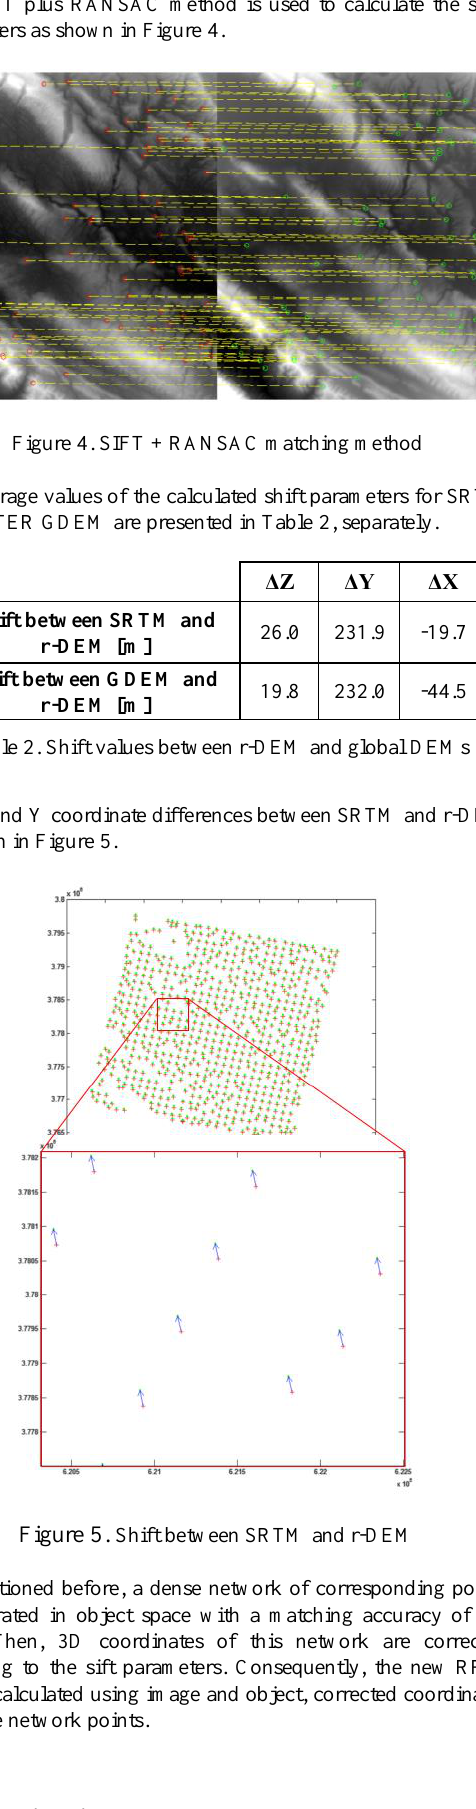
Figure 2. The selected region is a mountainous area with ca.